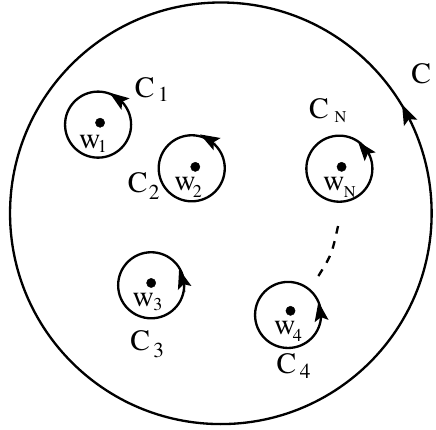
Figure 1 . Boundary contour C corresponds to the limit of large distances. It shrinks to the sum of contours C i , i = 1 , · · · N encircling points w i : C = F N